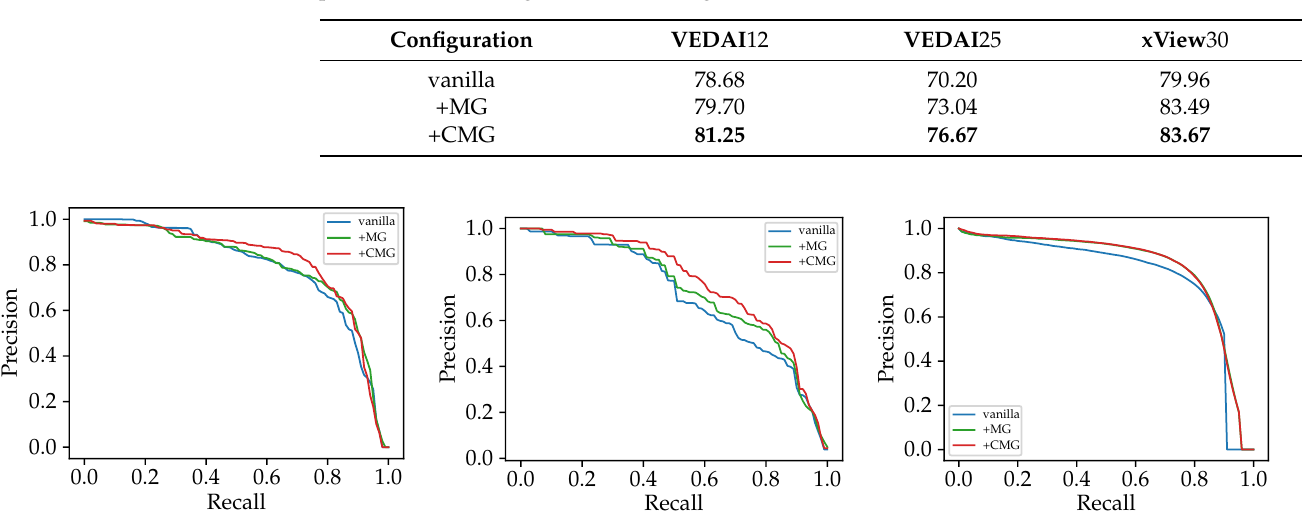
Table 4. Performance of YOLOX-s vanilla with mutual guidance (MG) and contrastive mutual guidance (CMG) on the 3 datasets. The contrastive mutual guidance strategy consistently out- performs other configurations, showing its benefit.